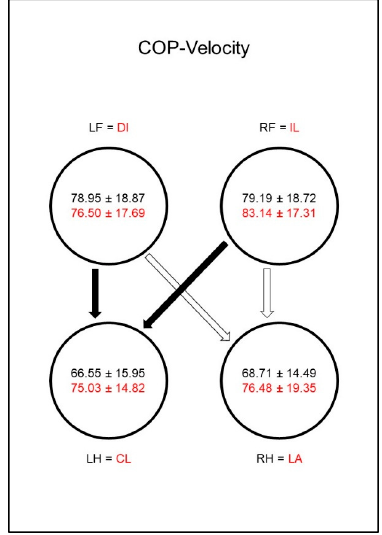
Figure 9. Speed of center of pressure movement in millimeters per second (COP-Velocity, mm/s) in study group 1 and control group. For detailed explanation and abbreviations refer to Figure 2.